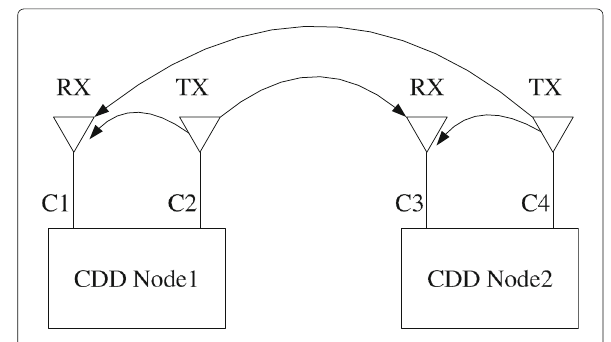
Fig. 2 Code Division Duplex